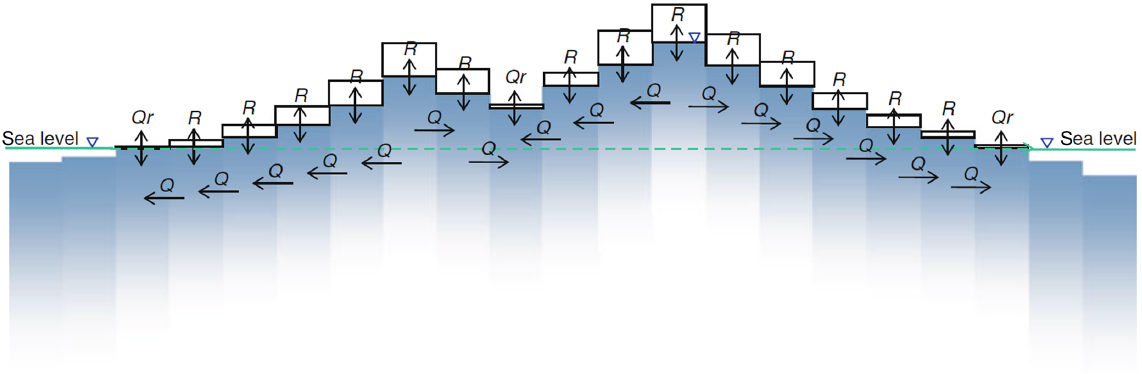
Figure A1. Schematic of the EWT model to simulate the water table at the continental scale, using recharge ( R ), horizontal groundwater flow ( Q ), groundwater discharge in rivers ( Q r ), and sea level (boundary condition). The blue fading colours indicate the decrease of hydraulic conductivity with depth (Fan and Miguez-Macho, 2010b, their Fig.